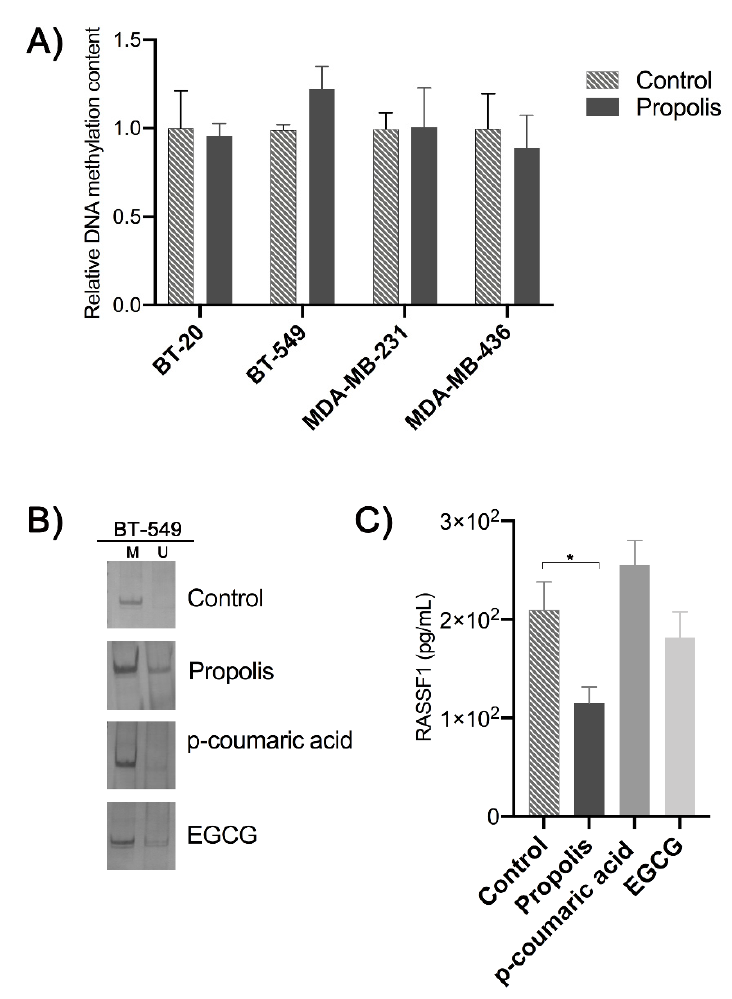
Figure 2. ( A ) Analysis of global DNA methylation content after propolis treatment relative to the respective control. ( B ) Locus-specific DNA methylation analysis by MS-PCR. BT-459 cells are fully methylated at the RASSF1A promoter region (M = methylated and U = unmethylated alleles). The in vitro treatment with propolis and EGCG was able to partially demethylate this locus, as evidenced by detection of the PCR product with primer-specific to detect the unmethylated DNA sequence. ( C ) RASSF1 protein expression levels in BT-549 cells after the in vitro treatment with propolis (10 µg/mL), p -coumaric acid, and EGCG (10 µM) during 96 h. * p < 0.05.